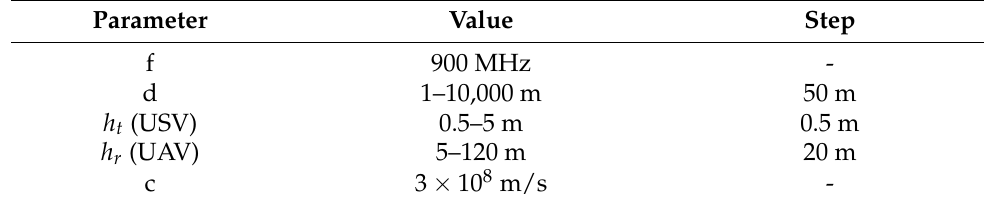
Table 5. Values of the parameters involved in simulations based on Equations (7)–(10): description and measure